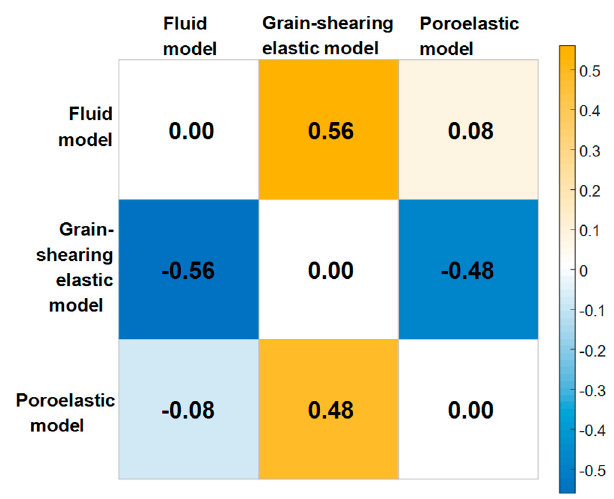
Figure 12. Comparison of Bayes factors calculated for each pair of models through Bayesian inference applied to backscattering strength data. Number superimposed over each matrix element is the base 10 logarithm of the Bayes factor for a given pair of models.